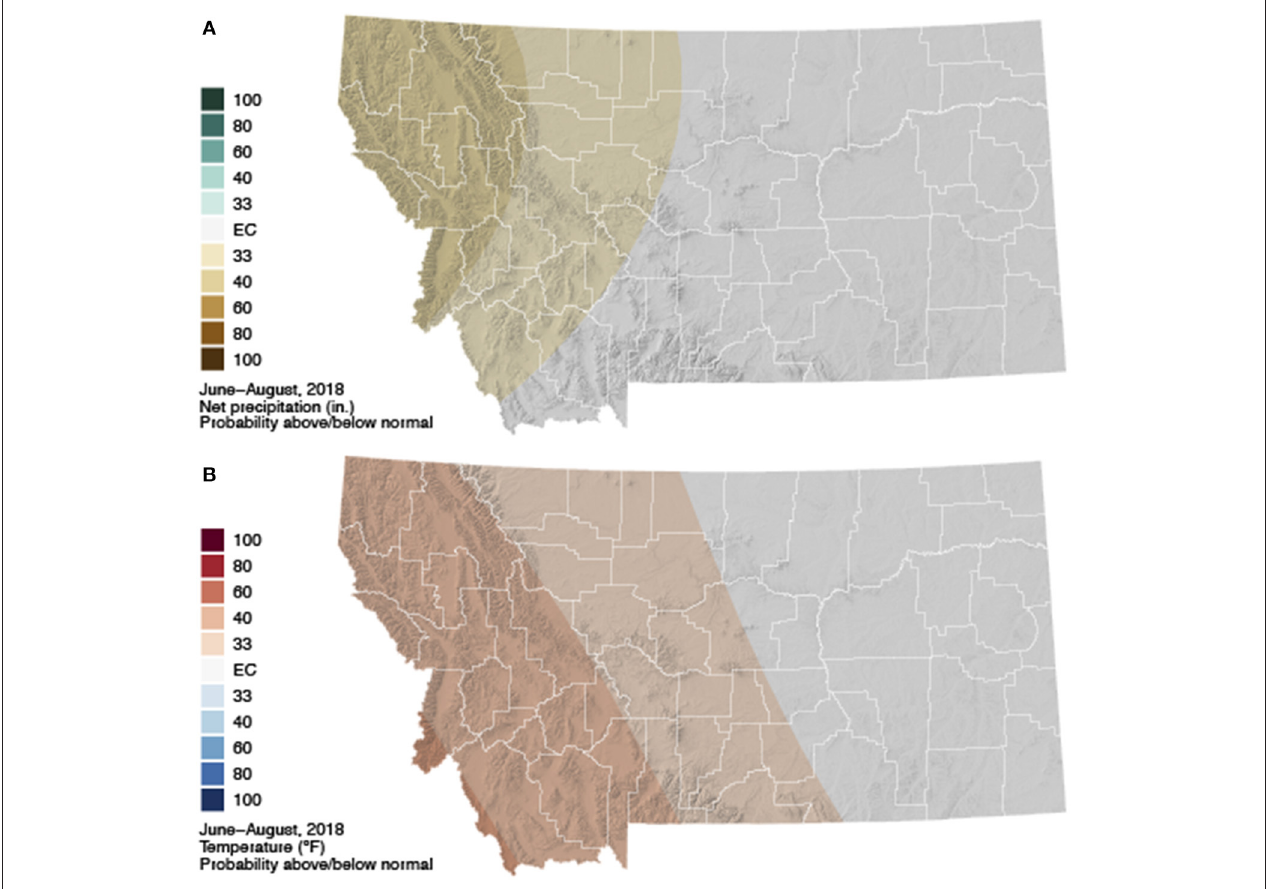
FIGURE 2 | Three-month seasonal climate forecasts (SCFs) for precipitation (A) and temperature (B) for June–August 2018. The three-month forecasts are presented as probability above or below normal conditions, defined as average conditions for the years of 1981–2010. Data are from NOAA’s Climate Prediction Center.